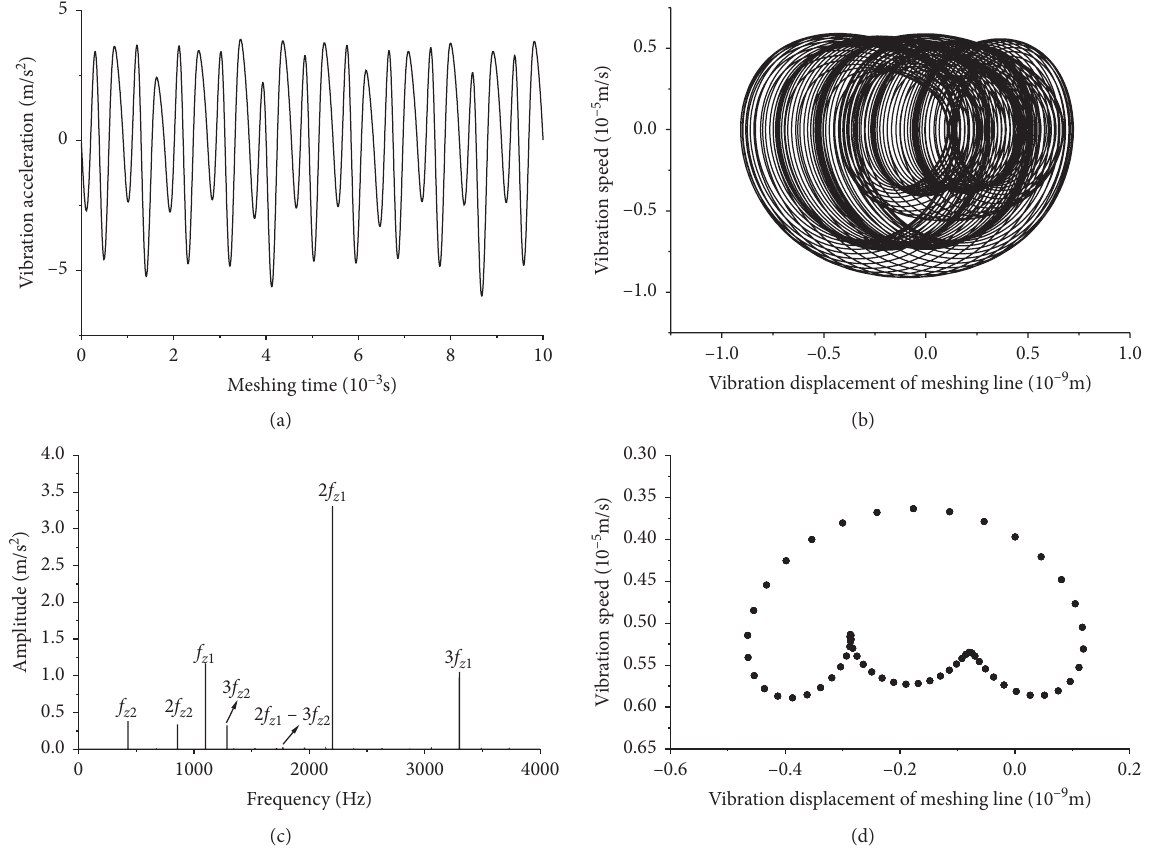
Figure 12: Vibration response of the output-stage gear pair of a two-stage helical gear transmission system at 3,000rpm: (a) time-domain diagram, (b) phase diagram, (c) frequency-domain diagram, and (d) Poincar´e